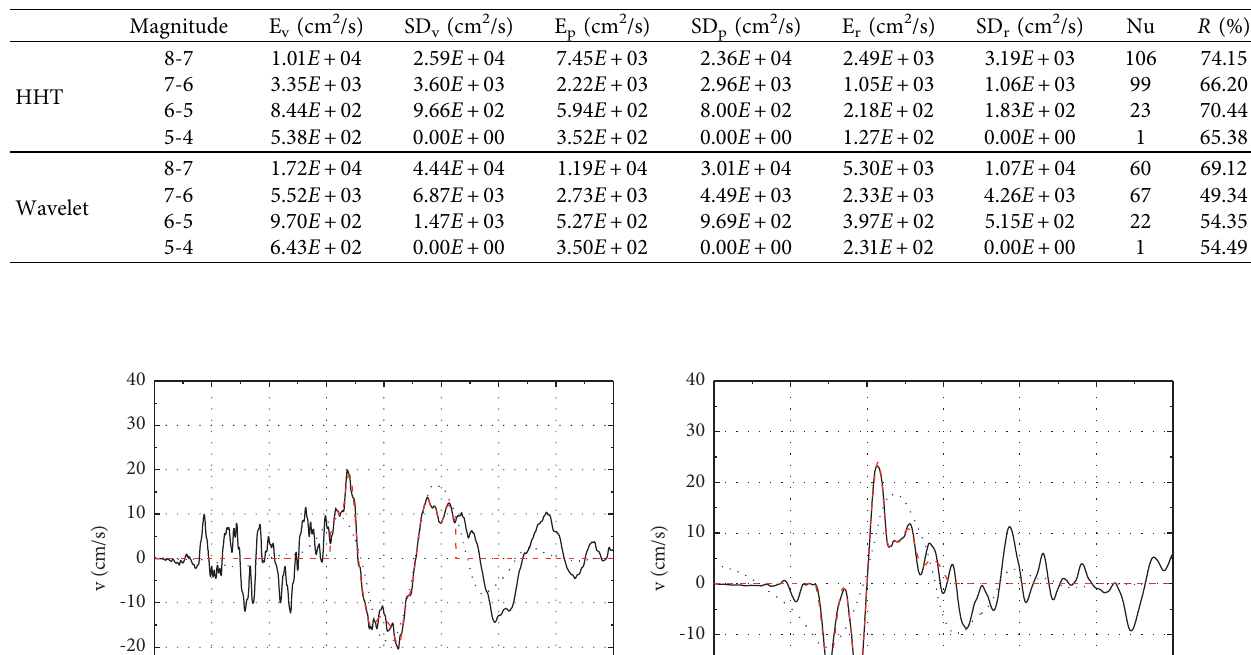
Table 5: The CSV table.